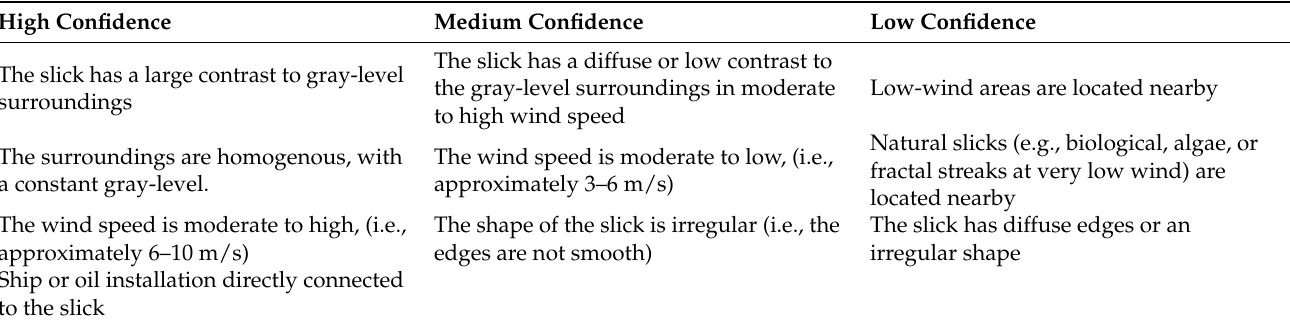
Table 1. Confidence levels for oil spill